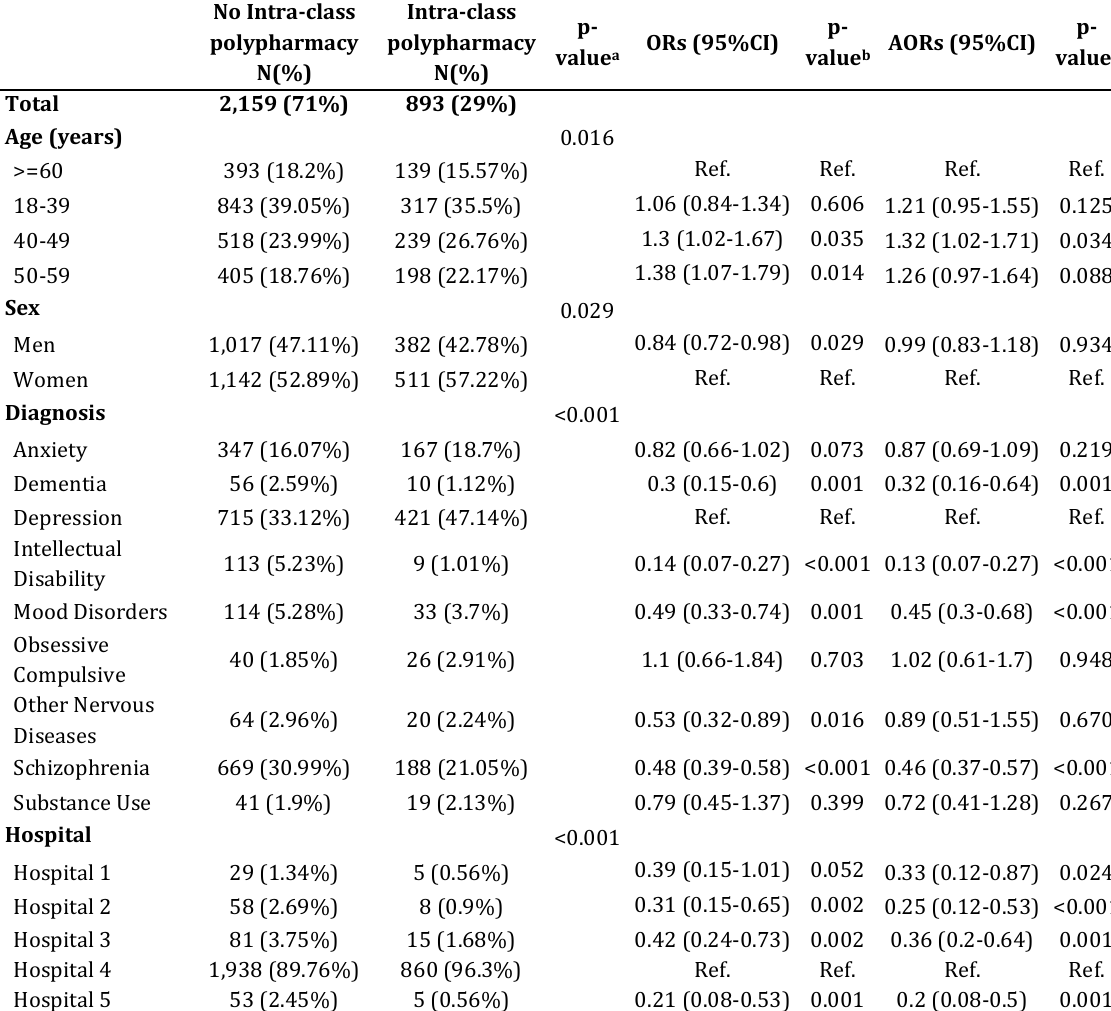
Table III Unadjusted and Adjusted odds ratios (ORs) for intra-class polypharmacy